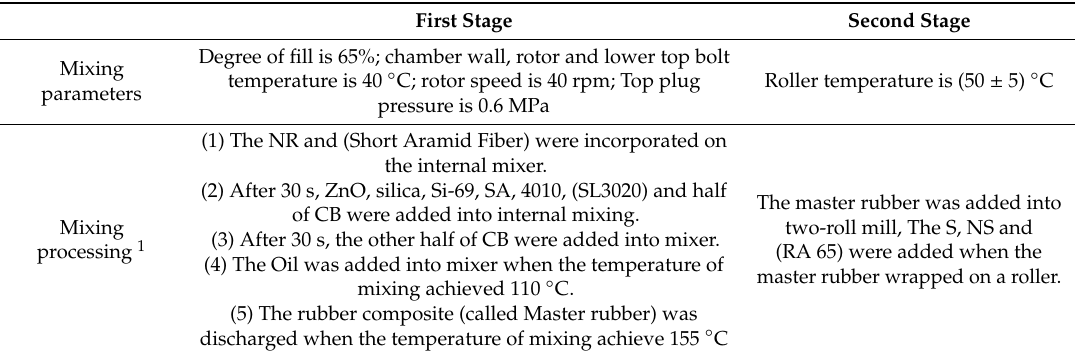
Table 2. Composite material mixing process.